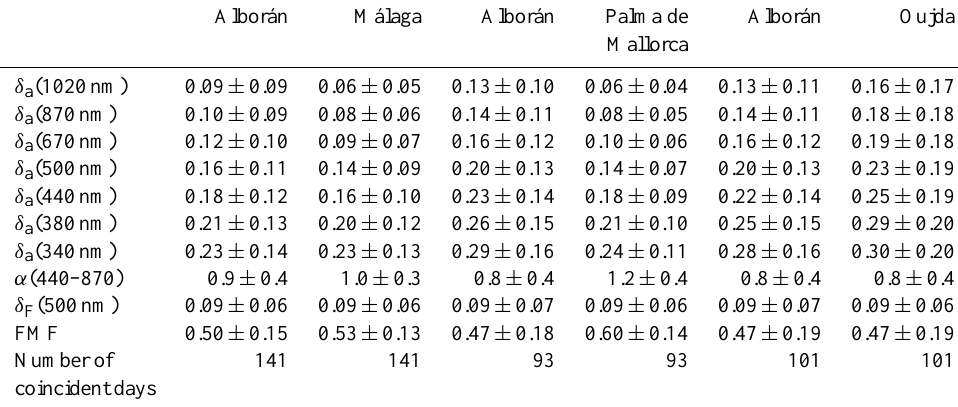
Table 2. Average values and standard deviations of δ a (λ) , α (440–870), δ F (500nm) and FMF from 1 July 2011 to 23 January 2012 for Alborán Island, Málaga, Oujda and Palma de Mallorca. Only days with coincident measurements at Alborán and at each one of the additional AERONET stations are used for direct comparison. Alborán Málaga Alborán Palma de Alborán Oujda